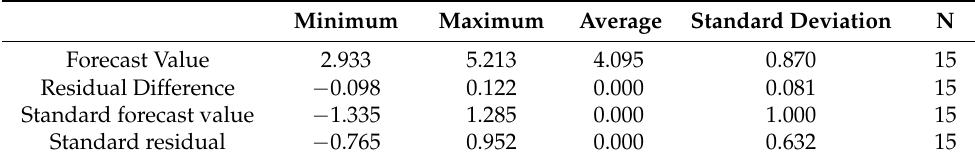
Table 7. Residual